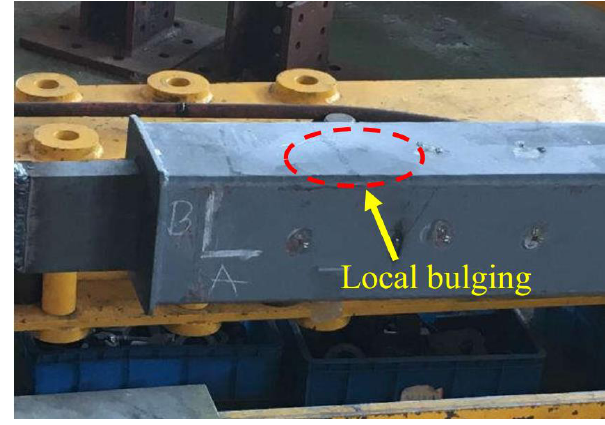
Figure 3. Out-of-plane deflection of the stiffening part.